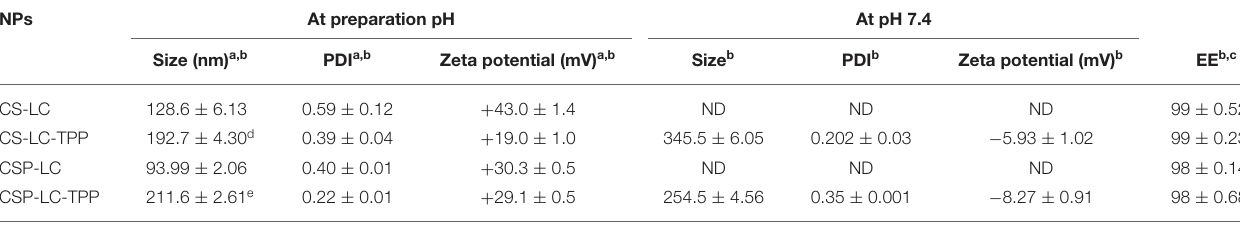
a Determined at preparation pH. b Each value represents the average of triplicate measurements ± standard deviation. ND: not determined because failed in transfection study.